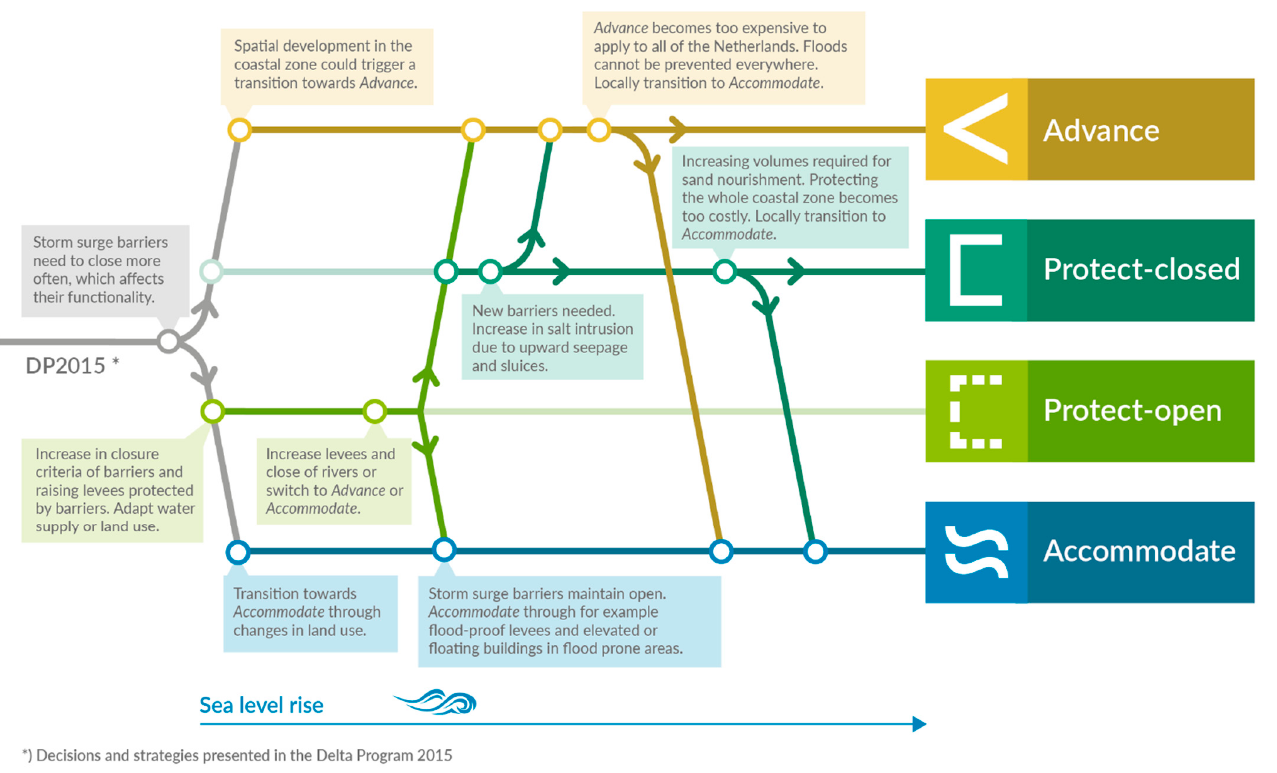
Figure 7. Adaptation pathways for the Netherlands to adapt to accelerated SLR. DP2015 represents the present strategies, adopted in 2014 [11]